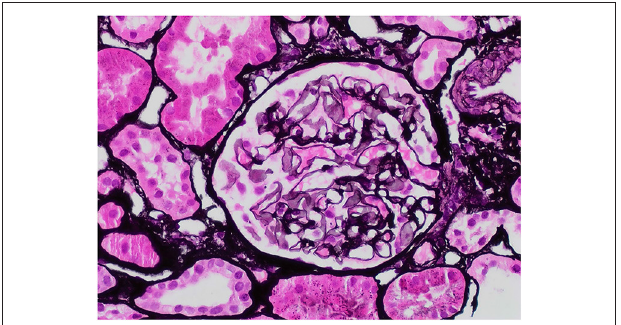
FIGURE 2 | Jones Silver, 40X: The glomerulus lacks well-developed “spikes” or “holes”.